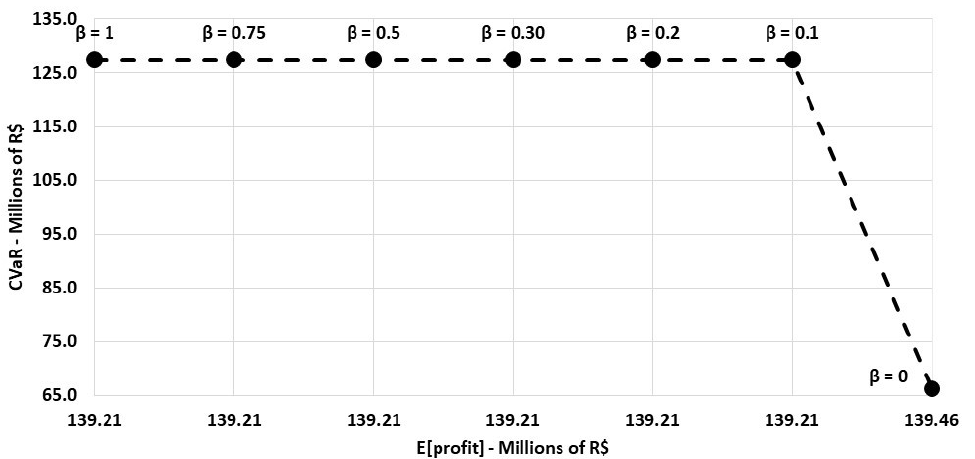
Figure 6. Efficient frontier for the deterministic